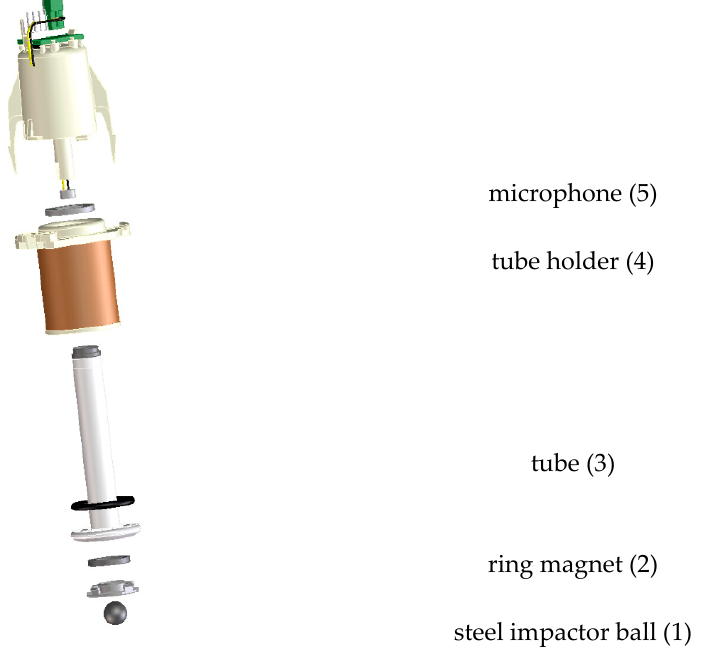
Figure 1. The impactor used for all measurements. It consisted of a plastic tube with a ring magnet at its lower end. Within the magnetic field, a steel impactor ball was positioned. A microphone positioned at the upper end of the probe “listened” to the bouncing of the ball. Picture provided by Moba BV.